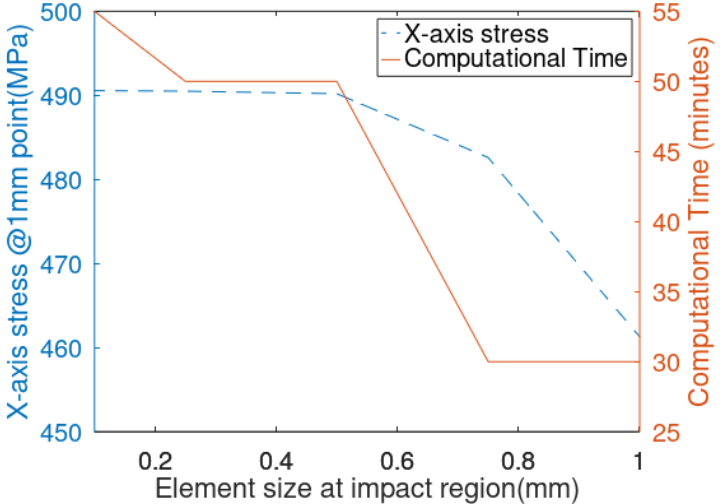
Figure 7. ( a ) Representative structured mesh used for the model with 4.00 mm target thickness. ( b ) Enlarged view of the point(Yellow) considered for x -axis stress.